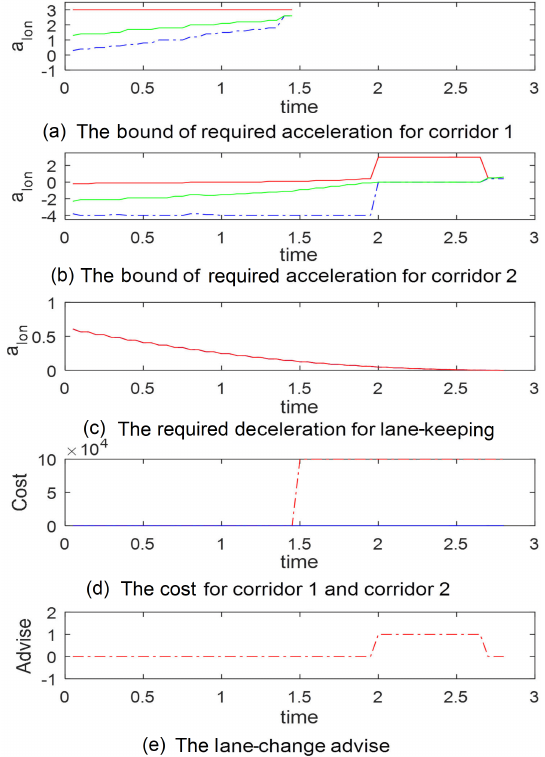
Figure 12. The maneuver evaluation result with a lon = − 2.5 m/s 2